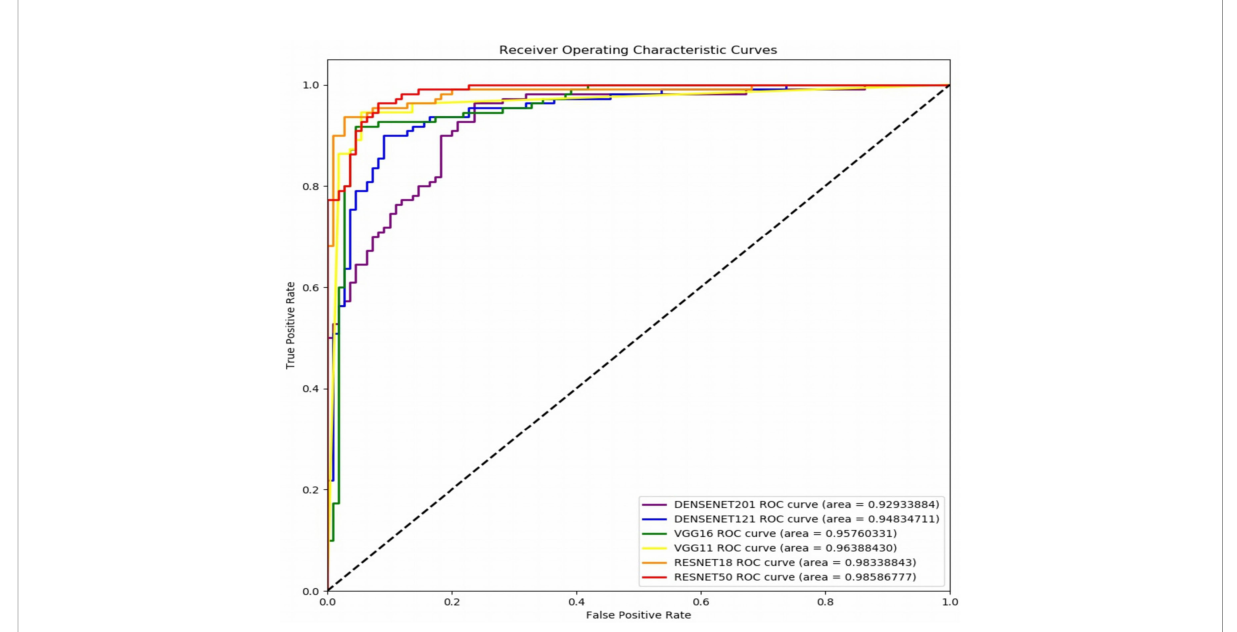
FIGURE 6 Receiver operating characteristic curves of the proposed network with ResNet-18, ResNet-50, VGG-11, VGG-16, DenseNet-121, and DenseNet- 201 backbones.